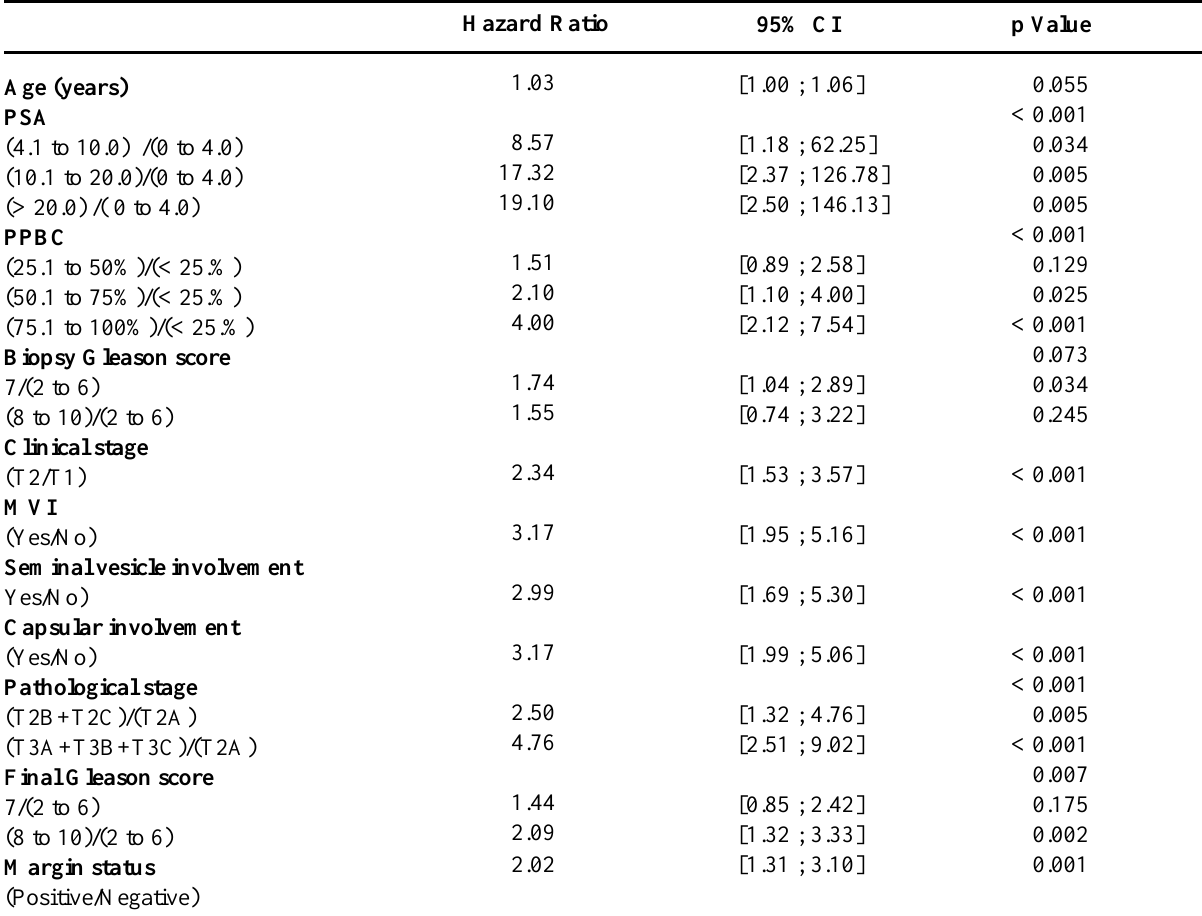
Table 3 – Cox regression for the risk of biochemical recurrence (univariate